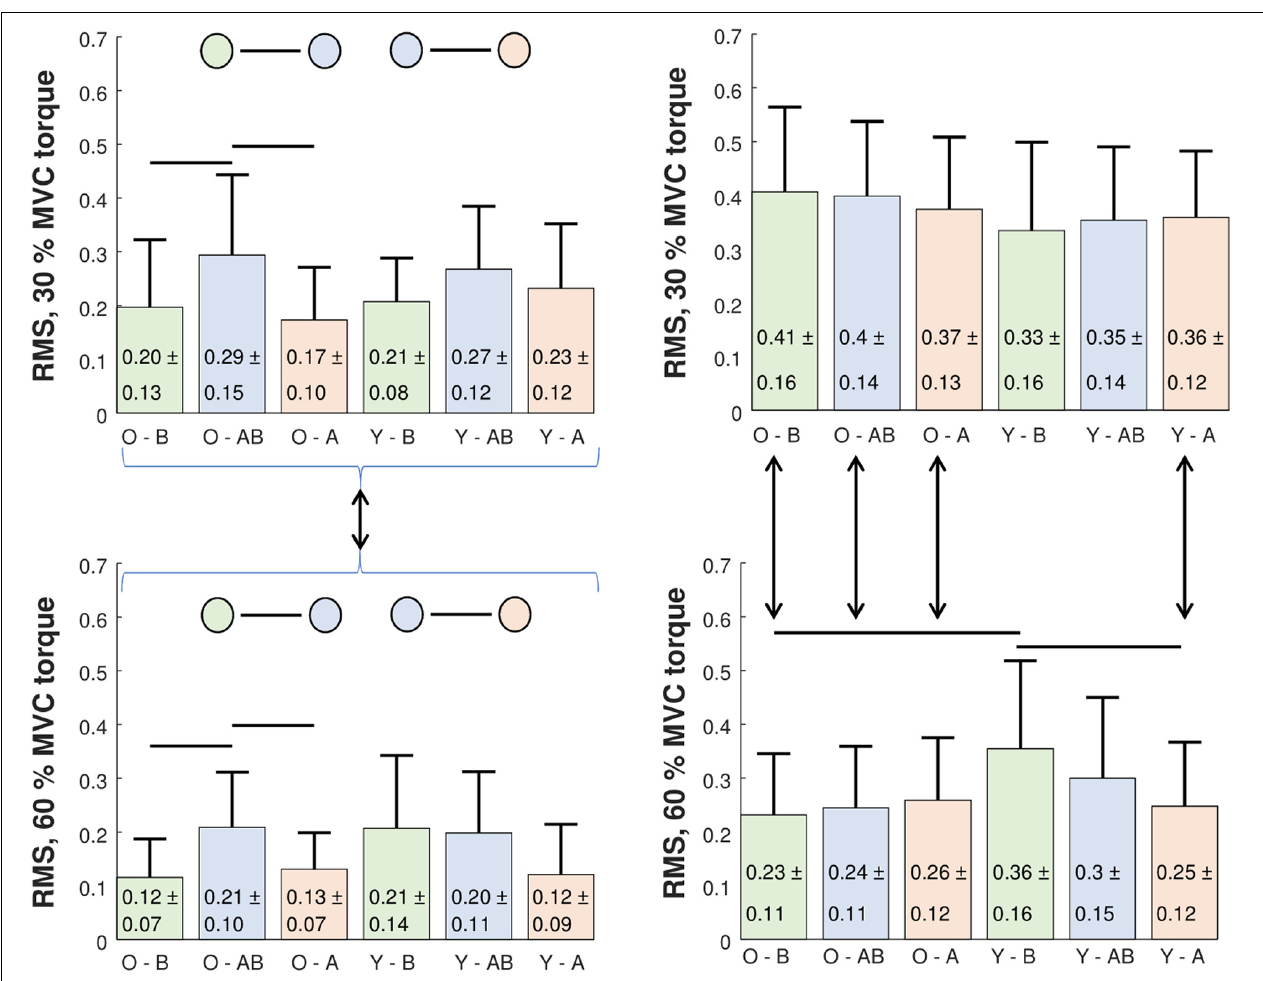
FIGURE 6 | Comparison of intra-person (left panels) and inter-person (right panels) RMS difference of cumulative spike trains‘ cross-correlation coefficients in older (O) and young (Y) participants at 30% (upper panels) and 60% MVC torque (lower panels). RMS differences were calculated across different trials before (B) and after (A) the bed rest (intra-session comparison), and between the trials of before and after bed rest sessions (AB, inter-session comparison). Statistically significant differences were estimated by a three-way Repeated Measures ANOVA test and are denoted by black lines (see the text for a detailed